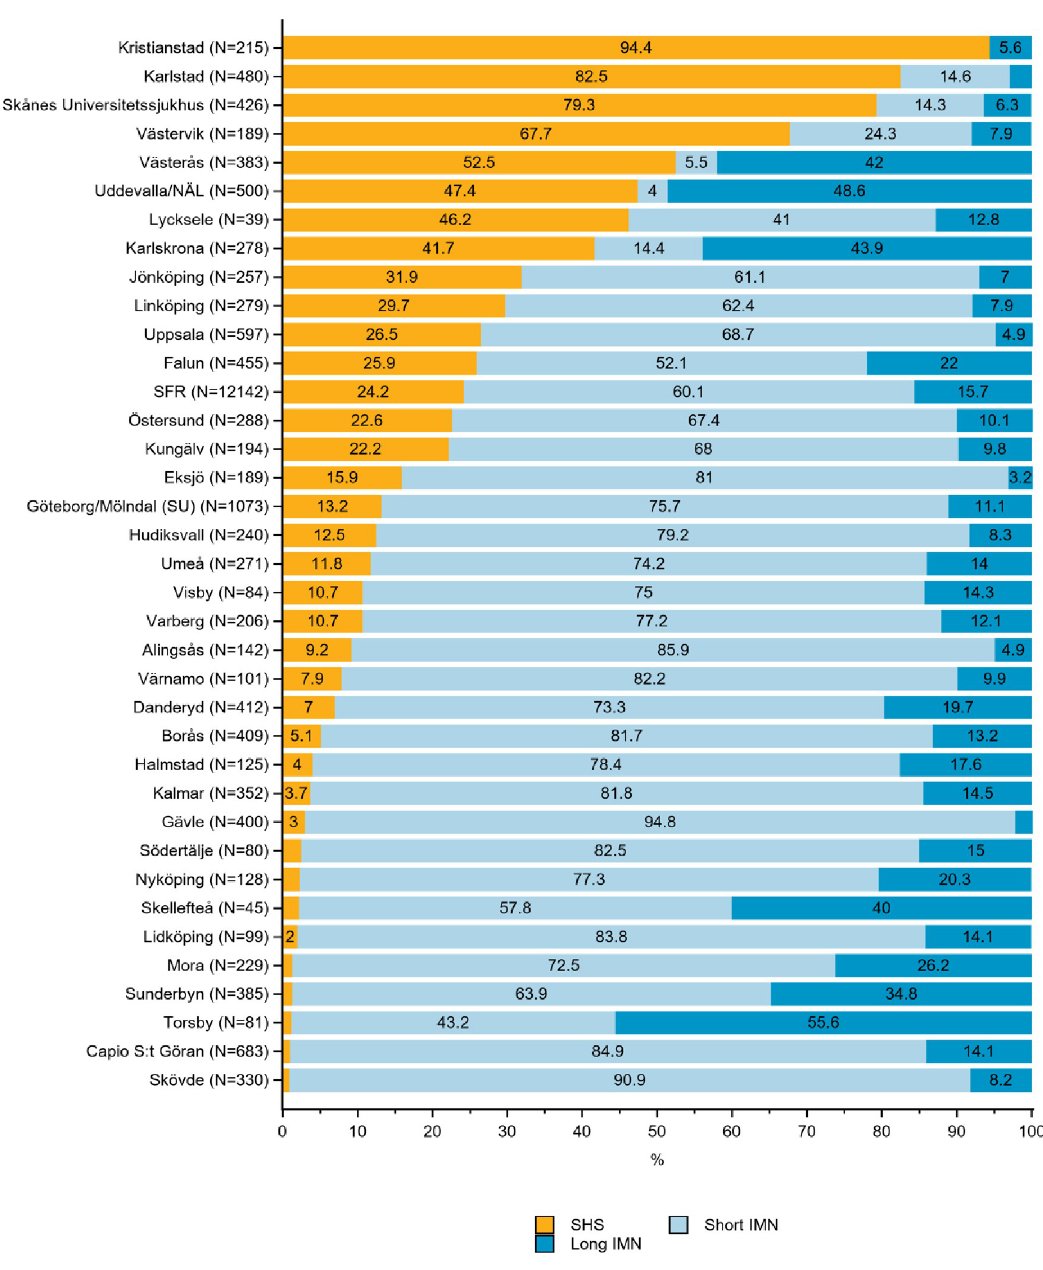
Fig 3. Distribution of sliding hip screw (SHS), short and long intramedullary nail (IMN) in the treatment of A2 trochanteric hip fractures by department in the Swedish Fracture Register in 2016–2020. SFR denotes all registrations in the Swedish Fracture Register (distributions are nationwide